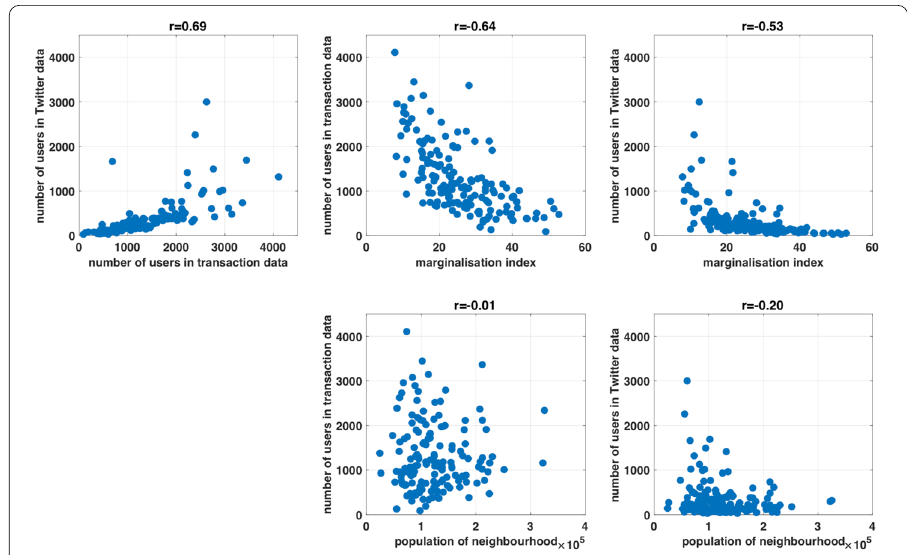
Figure 6 The relationship between the number of customers in the transaction data set, the number of users in the Twitter data set, and the neighborhood-level wealth, for the Latin American metropolitan area